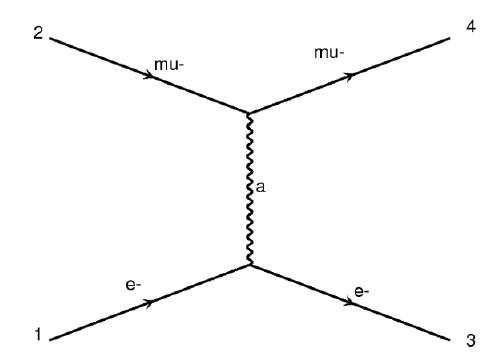
Figure 1 . Born diagram relevant to the process e(cid:22) ! e(cid:22)